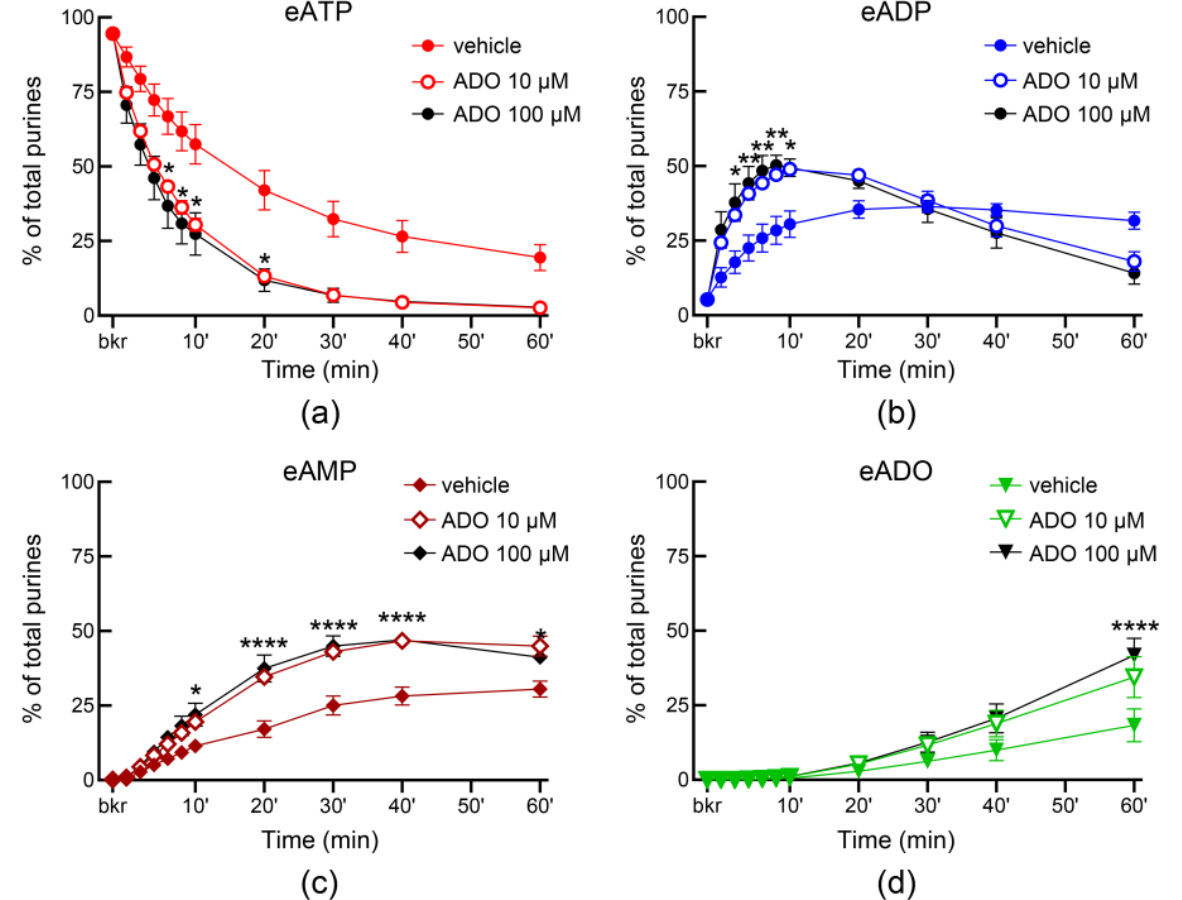
Figure 12. Effects of adenosine (ADO) on the release of soluble nucleotidases in the bladder lu- men. Time courses of eATP decrease ( a ), eADP increase ( b ), eAMP increase ( c ), and eADO increase ( d ) after addition of eATP to concentrated ILS collected at the end of bladder filling with either vehicle (KBS, n = 10) or ADO ( n = 4); n , number of bladder preparations. Note that the degradation of eATP was enhanced in ILS from bladders filled with ADO. * p < 0.05, ** p < 0.01, **** p < 0.0001 vs. vehicle control. 2 way ANOVA with Sidak’s multiple comparisons tests.